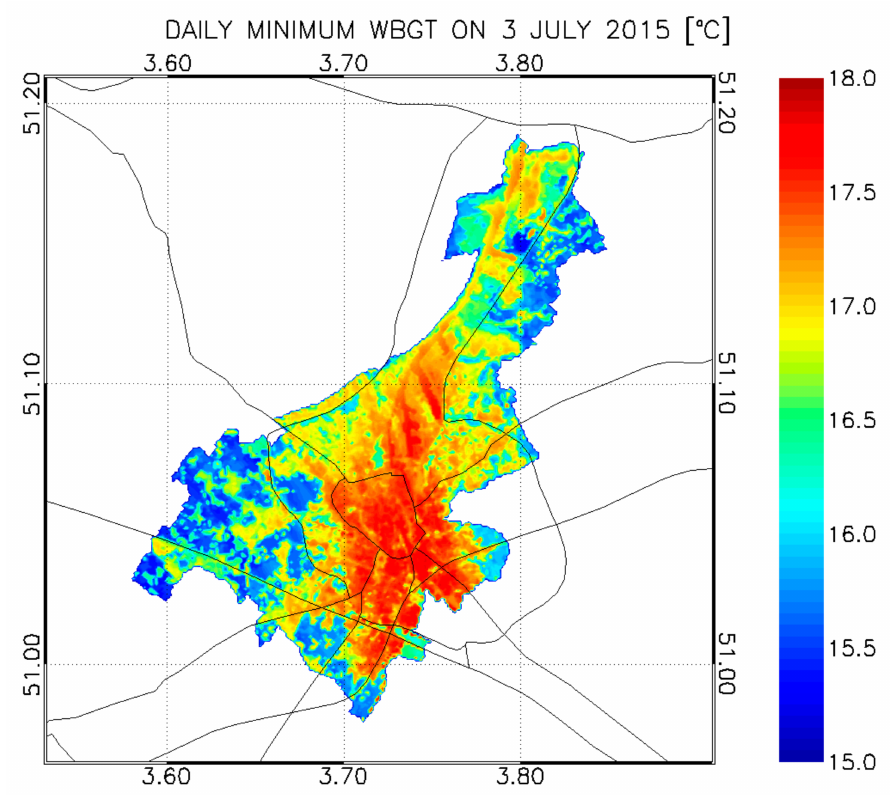
Figure 6. Map of the daily minimal wet bulb globe temperature for the city of